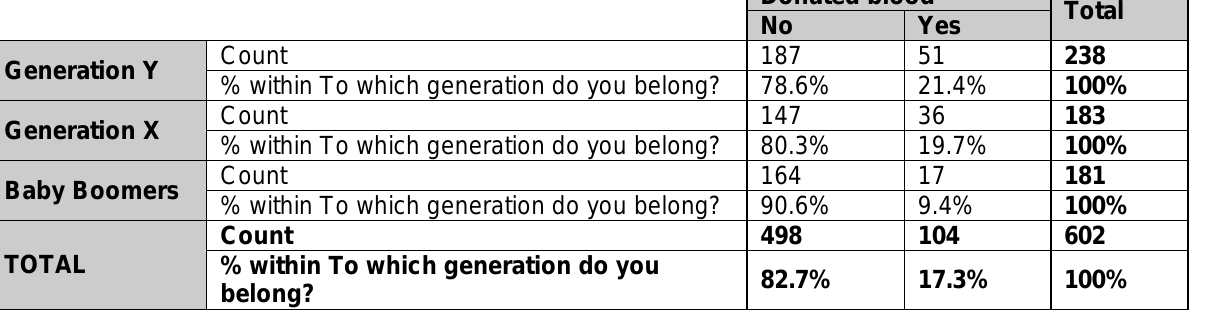
Table 4: Blood donations by different generations Generation Y